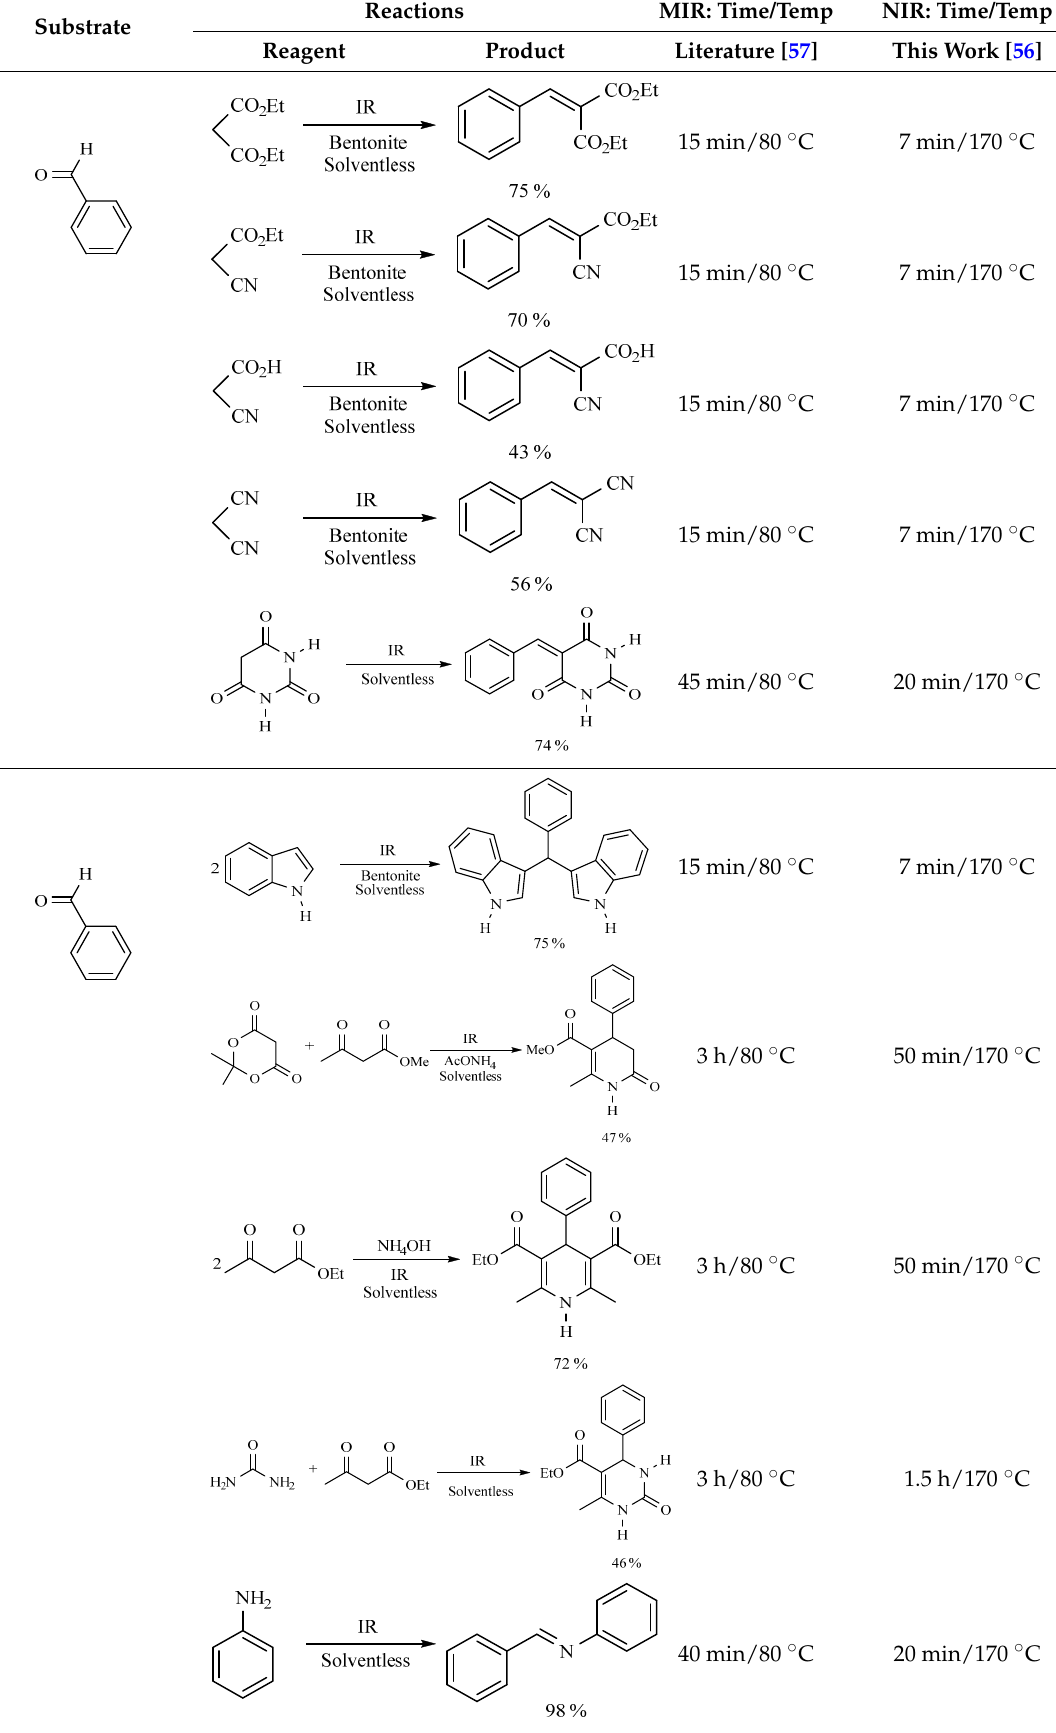
Table 1. Near vs. middle infrared irradiation for the completion of organic reactions.